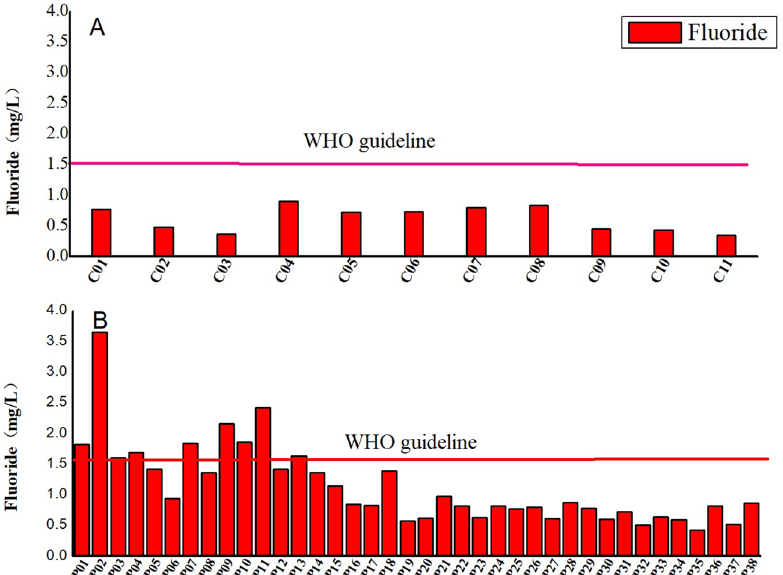
Figure 3. Comparison of mean fluoride concentrations in groundwater with WHO guideline of fluoride in drinking water: ( A ) Centralized groundwater sources. ( B ) Decentralized groundwater sources.